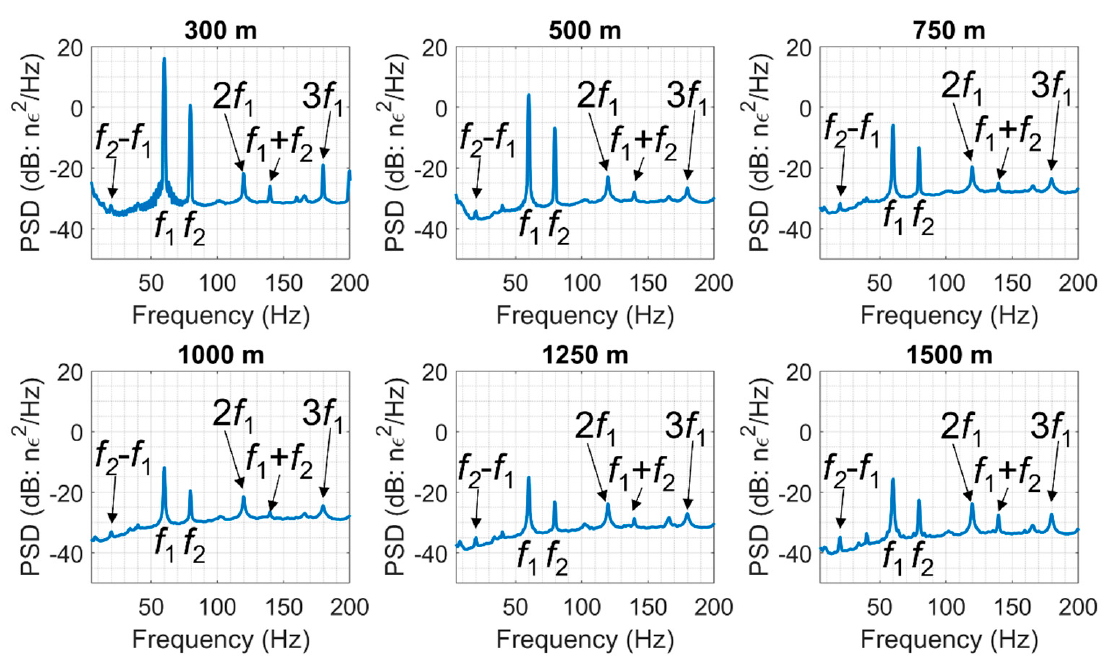
Figure 8. Power spectral densities of the DAS signals recorded 300, 500, 750, 1000, 1250, and 1500 m deep in the well during the warmup sequences of the SOV. Fifty sweeps were stacked together to increase the signal ‐ to ‐ noise ratio.